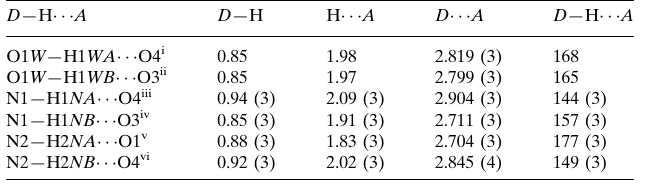
Hydrogen-bond geometry (A˚ , (cid:3)